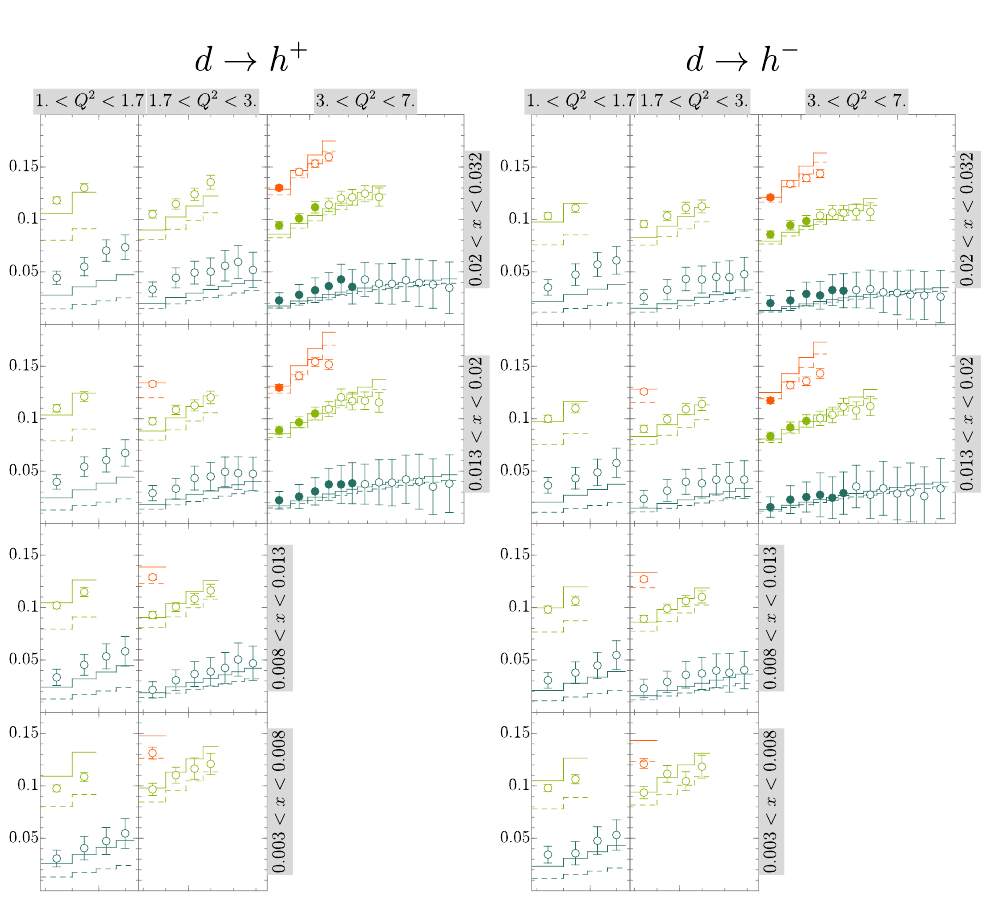
Figure 21 . Continuation of the plots 19 and